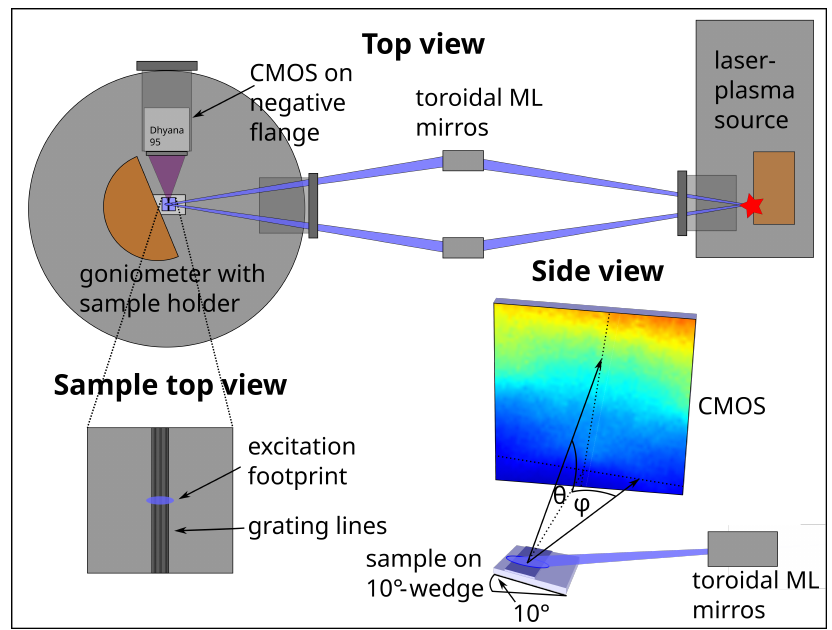
Figure 1. Schematic setup of the laboratory LPP measurement. The LPP vacuum chamber is depicted in the upper right corner of the top view of the setup as the source of soft X-ray radiation, the orange rectangle depicting the Cu target. The pair of toroidal multilayer (ML) optics is located between the LPP and the sample chamber. Note that both chambers and the optics are all kept under vacuum. In the sample chamber on the left, the sample is mounted on a 10°-wedge on a goniometer (in orange) for alignment and manipulation. The CMOS detector in white is mounted to an inwards-ranging negative flange. In the bottom right, a 3D side view of the sample on the 10° wedge with θ and ϕ and the detector are shown in detail, together with the exciting radiation focused by the ML optics. An exemplary interference pattern is depicted on the CMOS. On the bottom left, a schematic top view of the sample with the grating structure depicted as black lines and the excitation footprint in blue is